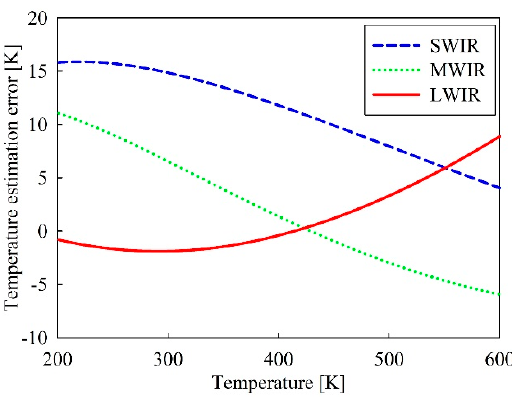
Figure 6. Error of estimated temperature according to temperature for three IR wavelength bands.